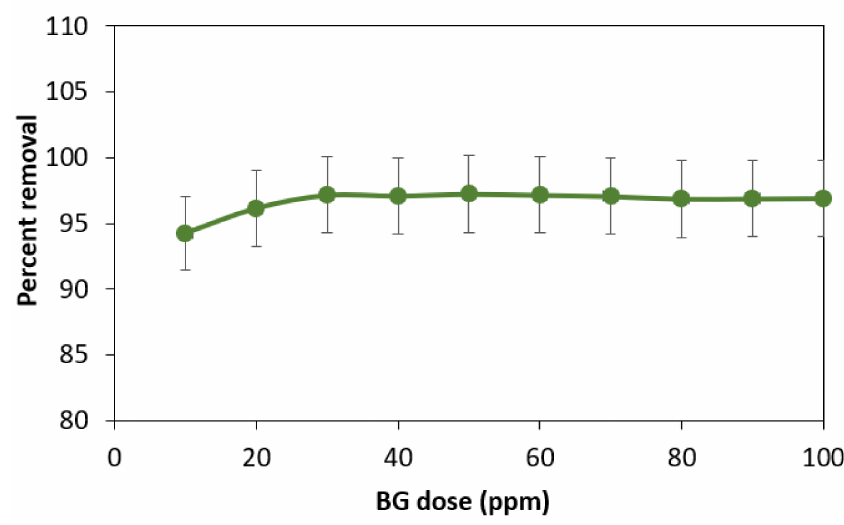
Figure 5. Effect of initial dye concentration on the percent removal of BG by selected adsorbate.